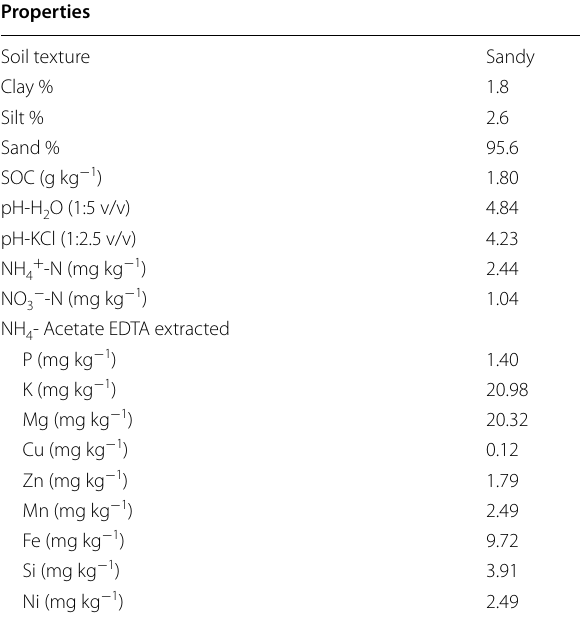
Table 1 Physicochemical properties of the coconut growing soil from Sri Lanka used for the green house root-exclusion